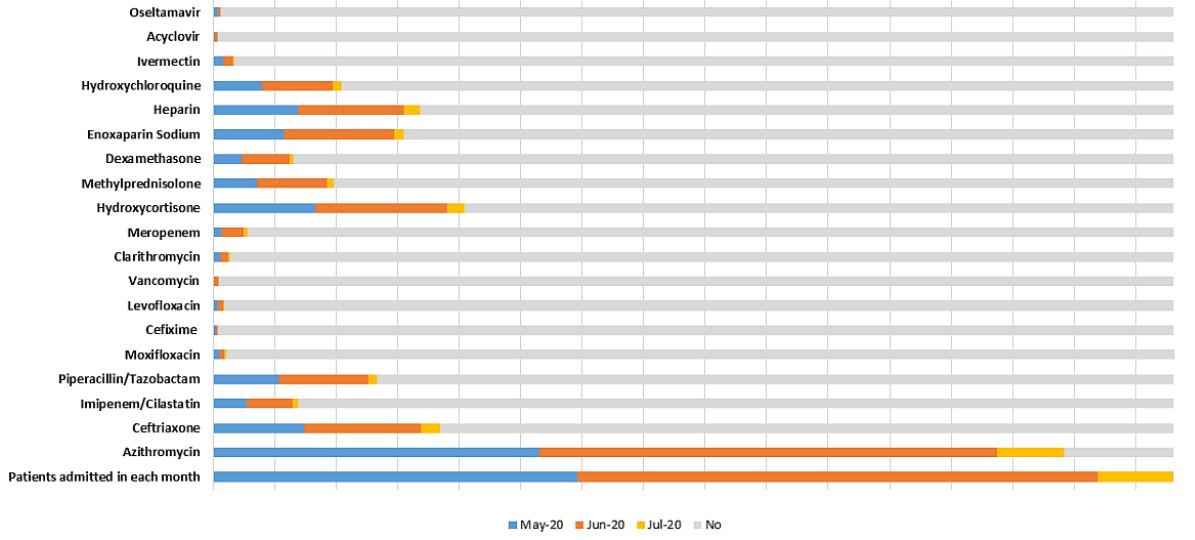
Figure 2. Relative distributions of different drugs administered to patients with COVID-19 in each month during the first wave of the pandemic (May-July 2020) in